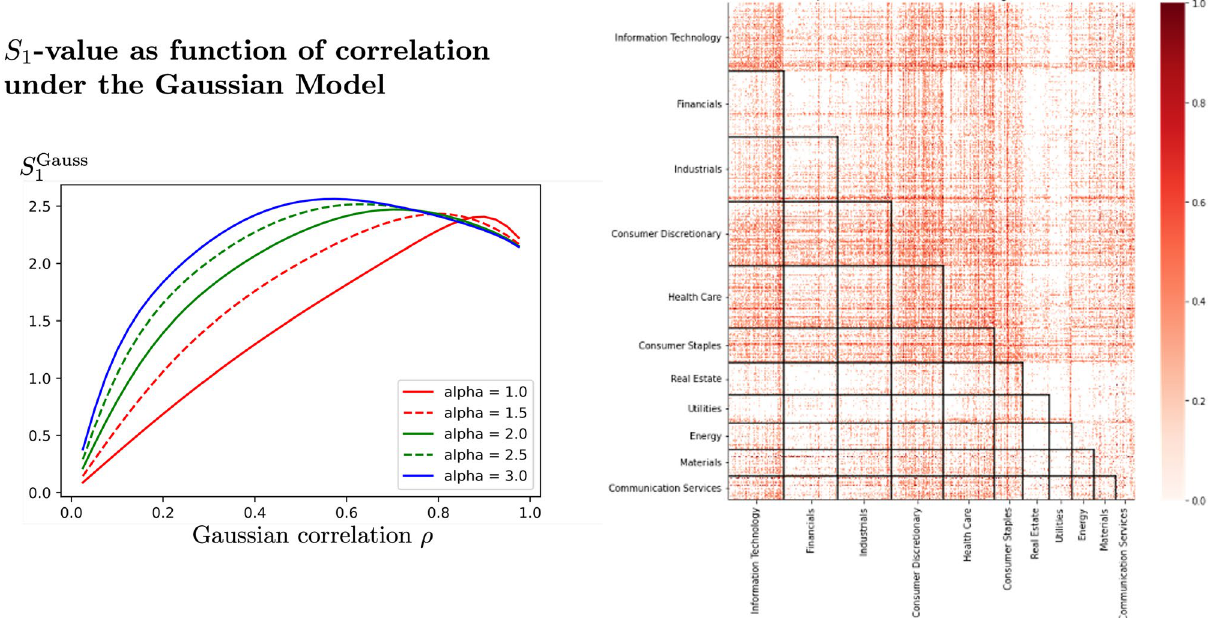
Figure 3. Gaussian Models. The lefthand side shows the S Gauss 1 -values computed via Monte Carlo simulation as functions of Gaussian correlation ρ , with thresholds taken as alpha multiplied by the respective volatility ασ A and r B ασ B , with α chosen in the range from 1 to 3). The righthand side shows a heatmap of (i.e. r A = = S emp S Gauss the positive excess (cid:31) 1 from daily closing price changes of S&P-500 stocks using the same time 1 − = period, GICS sector classification and ordering as in Fig. 1. For each pair of stocks, (cid:31) was computed by setting the threshold, that separates strong from weak days, to the stock’s daily volatility, as it was observed over the emp entire time period. Equation (1) was used to compute S 1 from the time series of historic stock prices, while the S Gauss 1 -value used was based on Monte Carlo simulations (as illustrated in Fig. 3 for positive values), with the historic correlation between the daily returns of the two stocks under